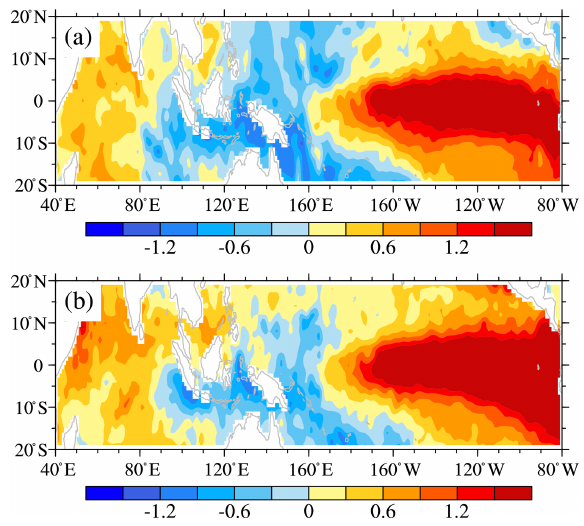
Figure 1. Maps of SST anomalies for (a) October 1982 and (b) September 1997 from the HadISST dataset (unit: ◦ C). The pe- riod from 1981 to 2005 is used to extract the monthly SST clima-